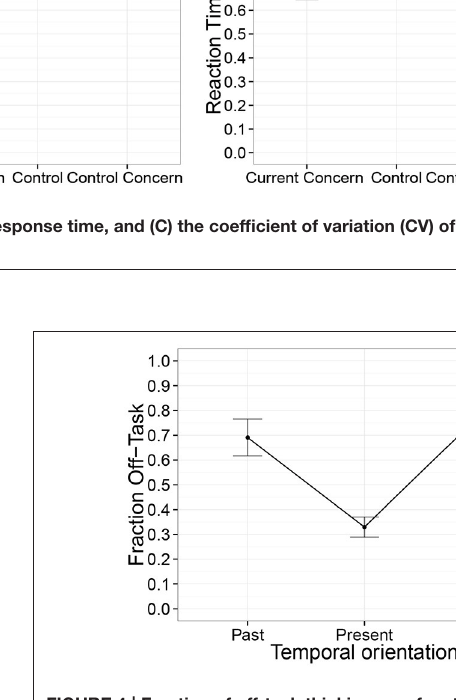
FIGURE 4 | Fraction of off-task thinking as a function of the temporal orientation of these thoughts. Error bars reflect standard errors. [ t (46) = 3.6, p < 0.001], but it did not differ between the participant’s own and other’s concerns [ t (46) = 1.1, n . s